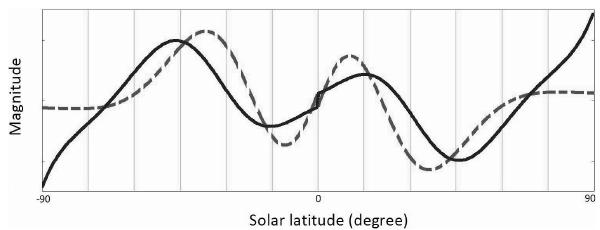
Fig. 2. Simulations for the two wave components of poloidal mag- netic field generated in the upper and inner layers (solid line and dashed line, respectively) reproducing reasonably close (within lim- itations of the simple model used as discussed in Sect. 4.1) the main features of the SBMF top curves in Fig. 1 obtained for cycles 21–23 (for details of comparison see the text). The following model pa- rameters are used: D 1 = − 700 and V =0.3 for the curve shown by the solid line and D 2 = − 700 and v = − 0.1 for the curve shown by the dashed